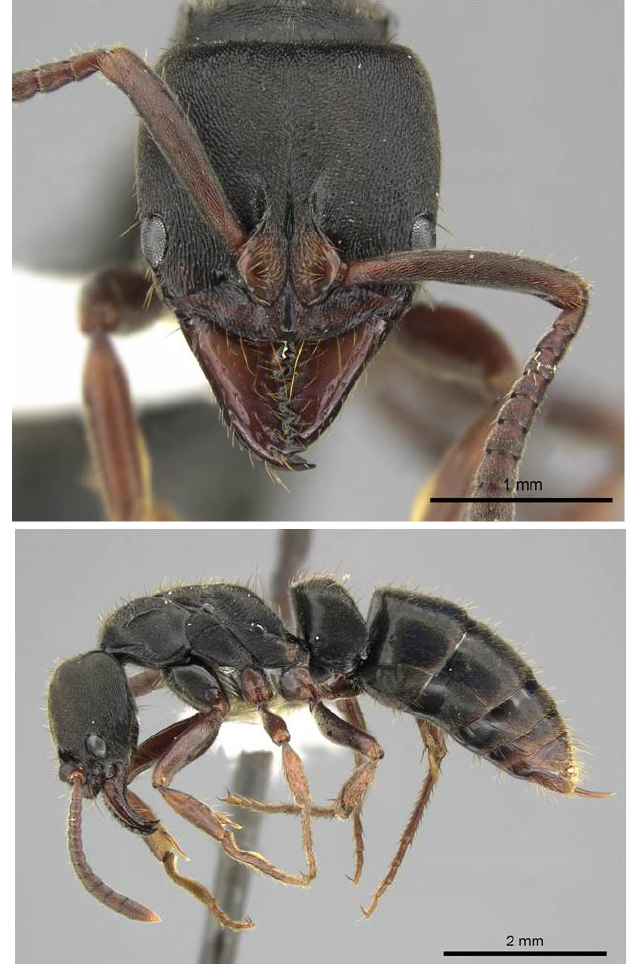
Fig 1 . Pachycondyla harpax . a) head and b) lateral view of worker from Costa Rica (CASENT0249149; P.S. Ward leg.; photos by R. Perry from